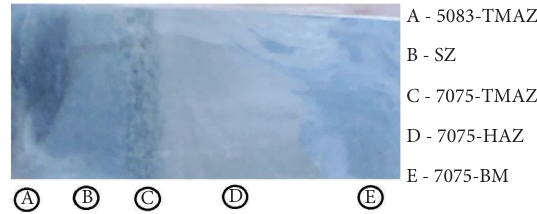
Figure 3: Macrostructures of the weld joint fabricated at 1100rpm.